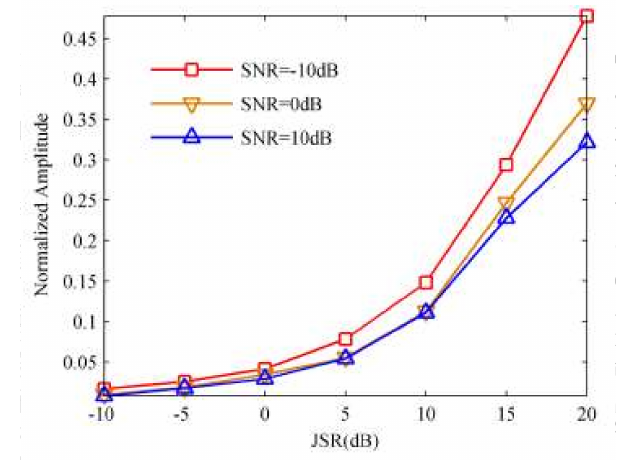
Figure 13. The normalized amplitude of suppressed false target versus the JSR in different SNR